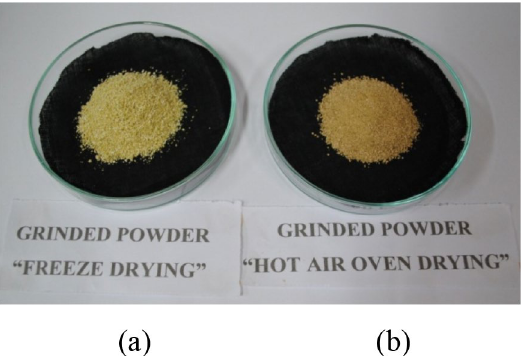
Figure 2. Grinded powder of dropped fruits of Citrus sinensis L. Osbeck—( a ) After freeze drying and ( b ) After hot air oven drying.